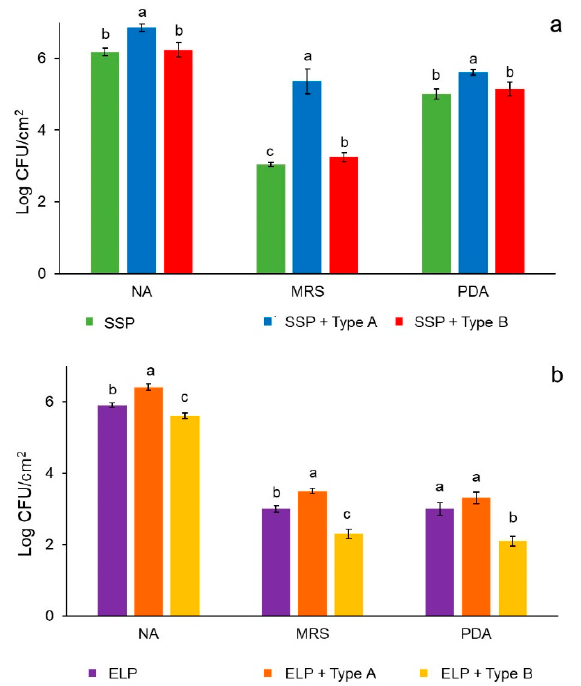
Figure 4. Microbial population recovered from 5-day biofilms formed on the surface of SSP plain and with type A or B deposits ( a ), and ELP plain and with type A or B deposits ( b ). NA = nutrient agar, MRS = de Man Rogosa Sharpe agar, PDA = potato dextrose agar.